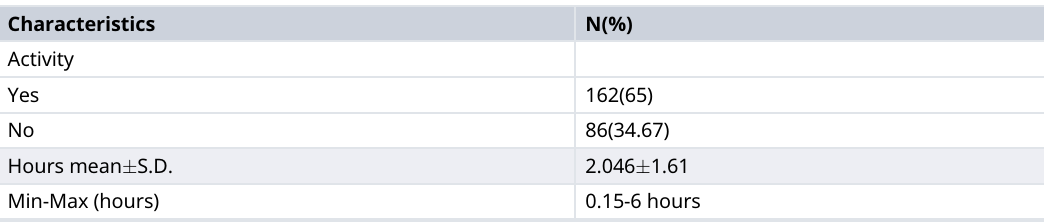
Table 3. Outdoor activity level of children.